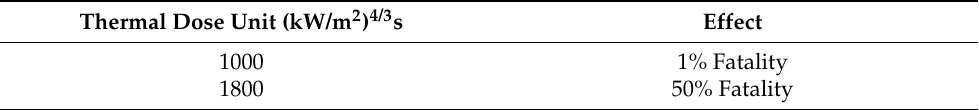
Table 7. Thermal dose fatality criteria. Calculations made based on data selected and extracted from